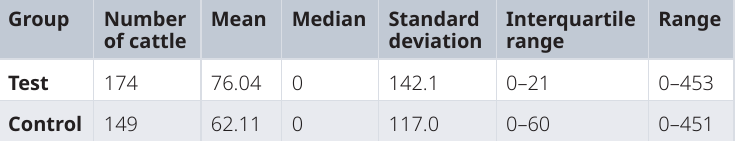
Table 6. Summary statistics for days to conception (DTC) for test and control groups.